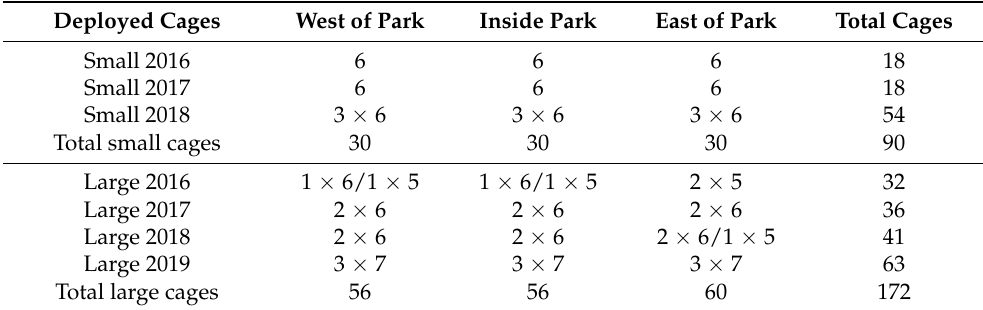
Table 1. Number of deployed small and large cages and rounds of deployments throughout the sampling period of different years at the three sampling locations. Deployed Cages West of Park Inside Park East of